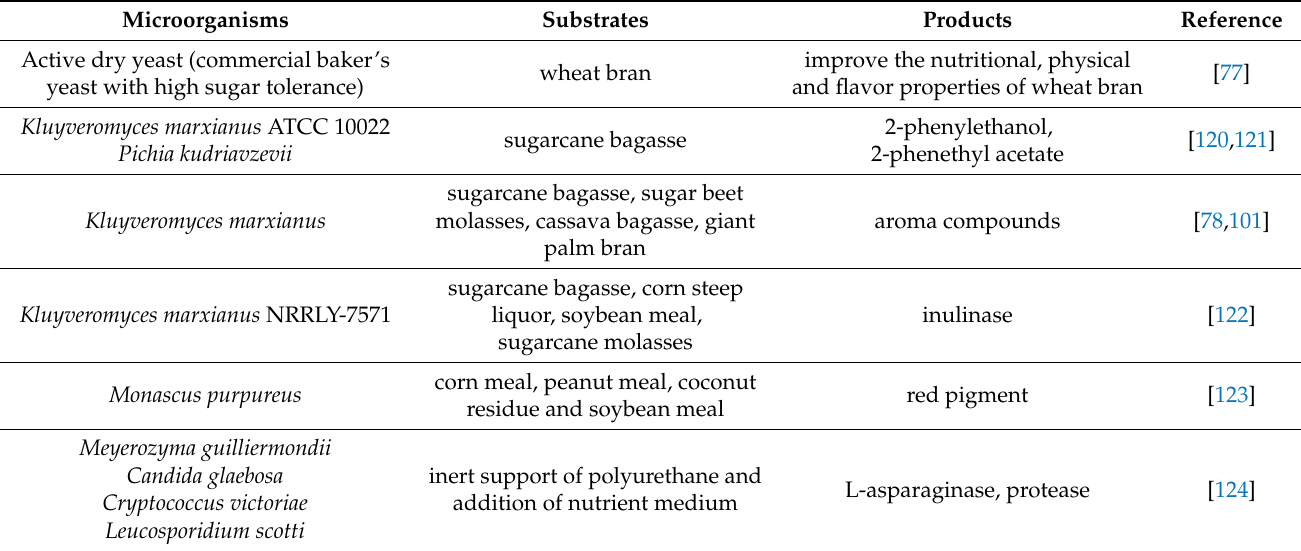
Table 5. Yeasts used in SSF for production of different